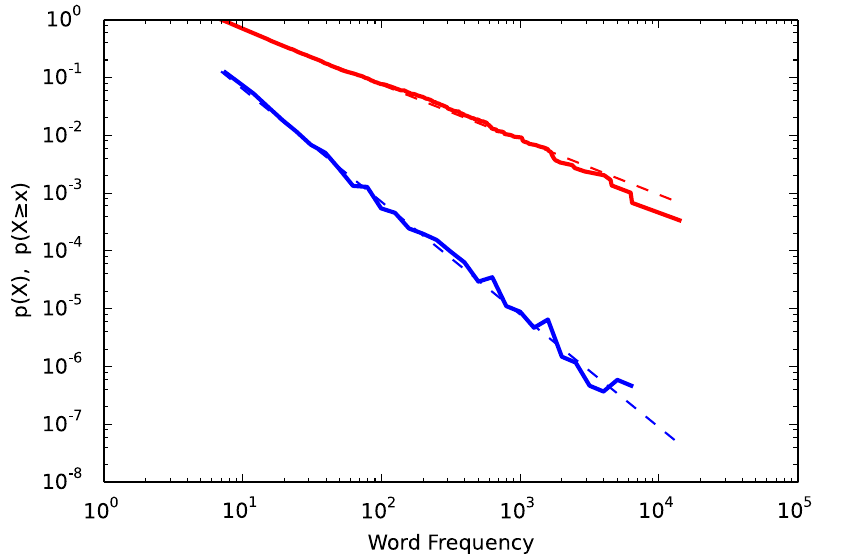
Figure 2. Probability density function ( p ( X ) , blue) and complemenatary cumulative distribution function ( p ( X § x ) , red) of word frequencies from ‘‘Moby Dick’’.